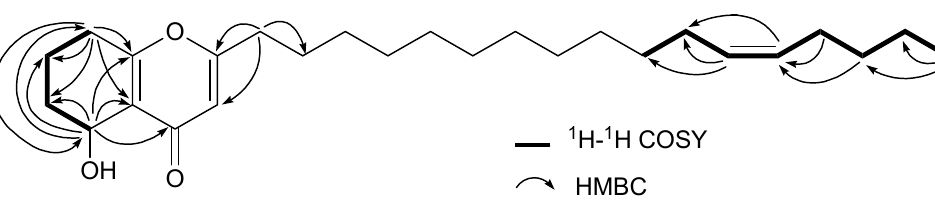
Figure 4. Key 1 H- 1 H COSY and HMBC correlations of 2